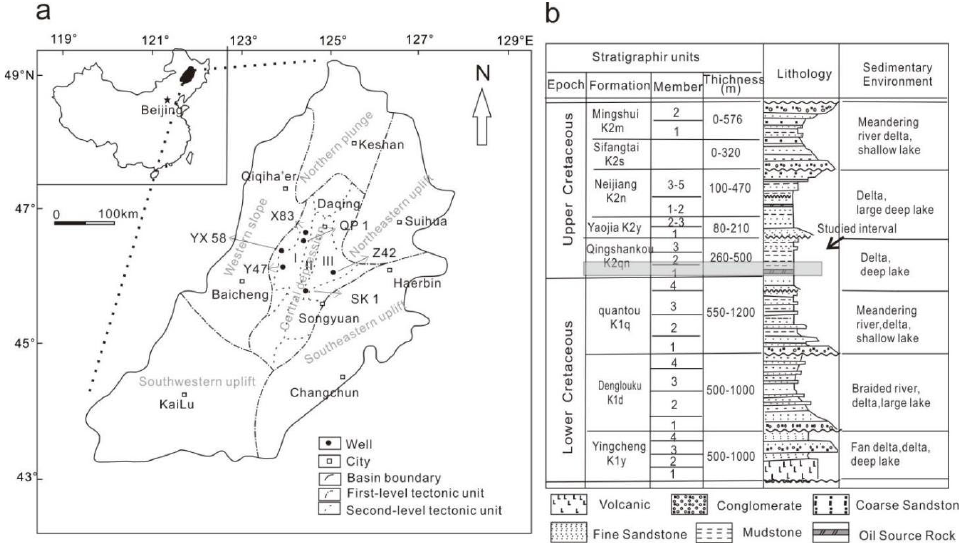
Figure 1. ( a ) Structural units of the Songliao Basin and sampling well locations (note: I Qijia-Gulong Sag, II Daqing Anticline, and III Sanzhao Sag); ( b ) stratigraphic units and studied interval.